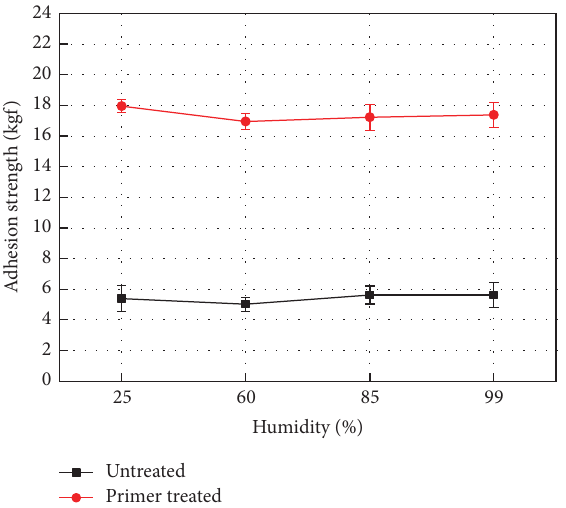
Figure 11: Adhesion properties of humidity aging at 25, 60, 85, and